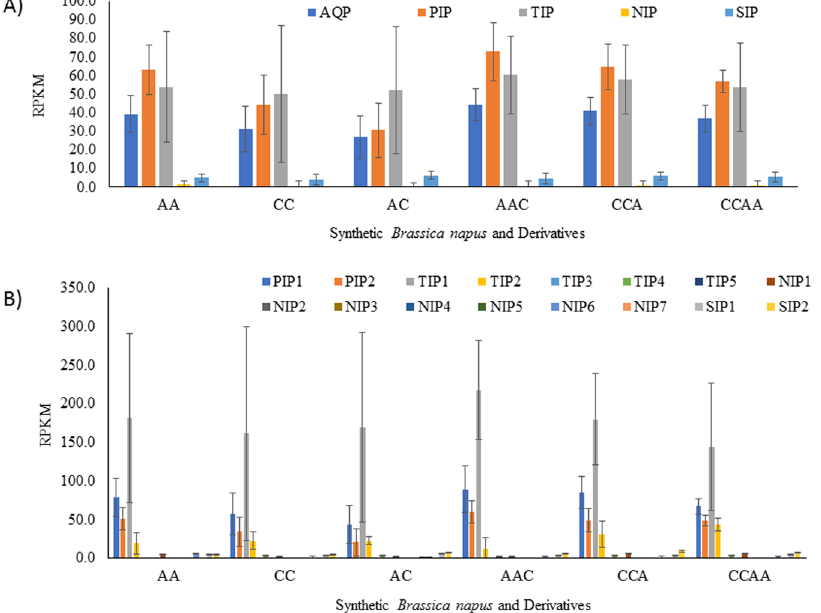
Figure 9. Expression of aquaporins (AQPs) in B . rapa (A genome, 2n = 20) and B . oleracea (B genome, 2n = 18) parents and their synthesized progenies with different copies of sub-genomes (AC, AAC, CCA, CCAA) retrieved from Bioproject PRJNA322687. Graphs are showing expression level in term of average reads per kilobases of transcript per million mapped reads (RPKM) for ( A ) four AQP subfamilies namely PIP, Plasma membrane intrinsic protein; TIP, Tonoplast intrinsic protein; NIP, Noduline-26 like intrinsic protein; SIP, Small intrinsic protein; and ( B ) groups in each subfamily. RNA-seq expression data was obtained from Tan et al . (2016). Bars represent standard error from the mean for all values within a subfamily or a group out of six samples from two biological replicates. Detailed data are provided in Supplementary Dataset